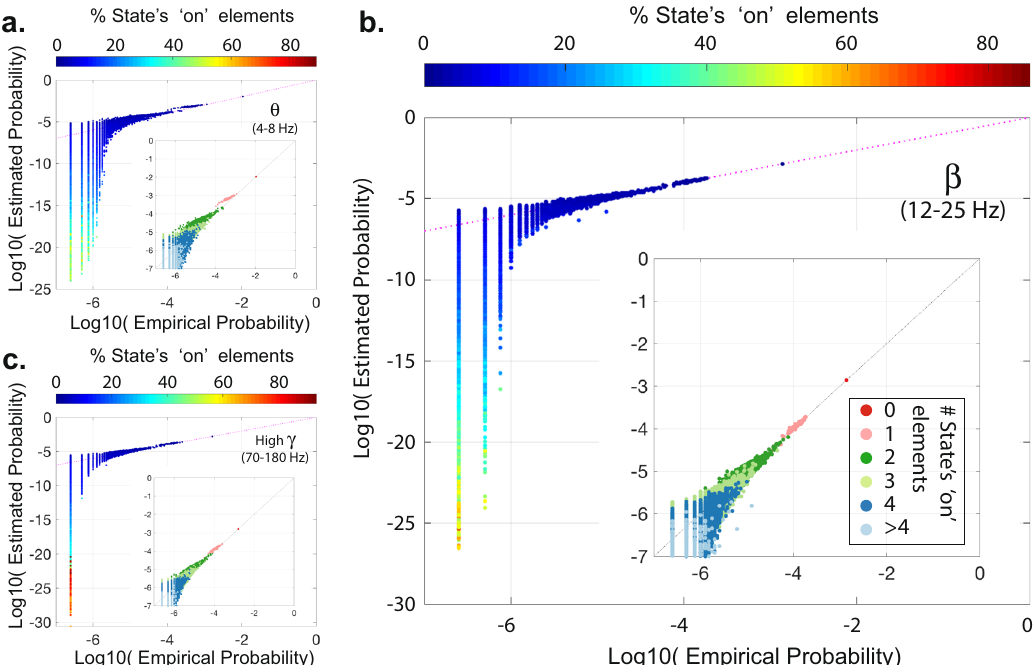
Fig. 7 Empirical and estimated probabilities of all observed states. Plots represent the empirical and estimated probabilities of all observed states from a representative patient (#5) at θ (a) , β (b) , and High γ (c) bands using local montage and state binarization threshold of ‘ 1 ’ . The co-activation states ’ size (i.e., the percentage ‘ on ’ elements of states) is color-coded based on the color bar on top of each panel. Insets depict the highest probability states within their respective frequency band. States in the inset-plots are also color-coded based on the number of ‘ on ’ elements of each state (see panel b for color-code legend). Supplementary Fig. 15 shows the results for all fi ve